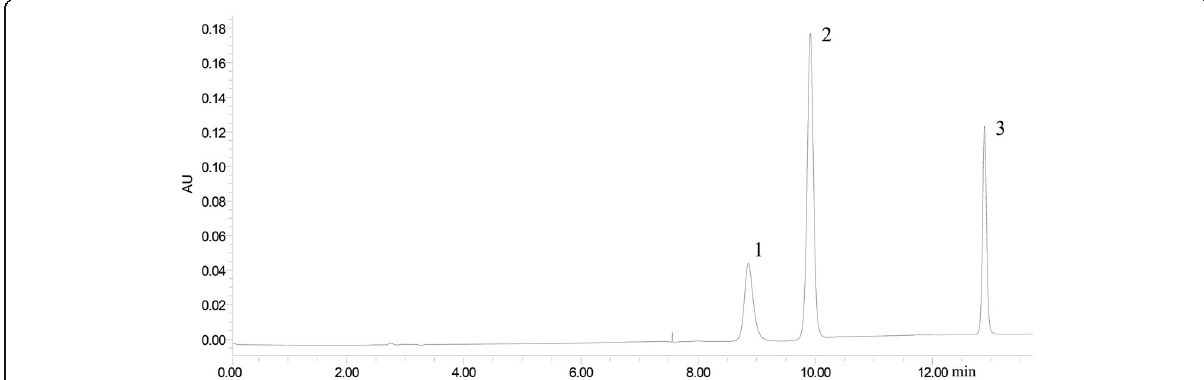
Fig. 1 The HPLC of Curcumin, Resvertrol and TMP. The HPLC chromatogram of standard substances monitored at 254 nm. Peak 1, 2, 3 are TMP, Resvertrol, and Curcumin, respectively